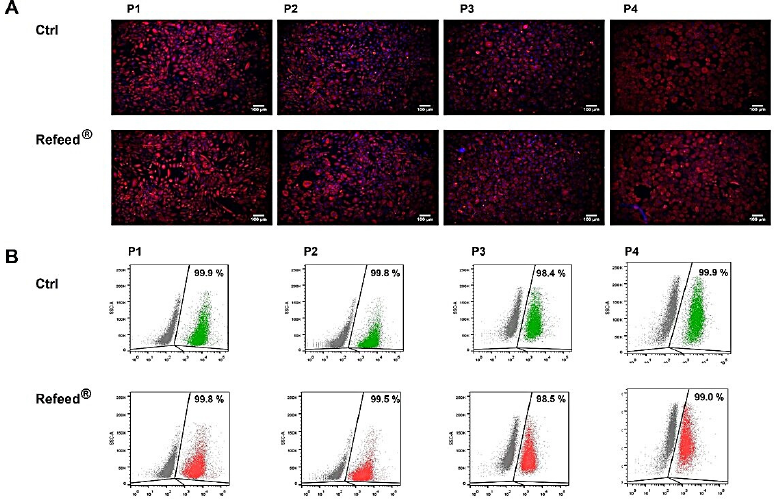
Figure 4. Expression of Pan-Cytokeratin (Pan-Ck) in human Amniotic Epithelial Cells (hAECs) cultured with and without Refeed ® supplementation. hAECs were cultured in basal medium (Ctrl) and in basal medium with Refeed ® supplement from passage 1 to passage 4 (P1–P4). ( A ) Immunofluorescence microscopy for the analysis of Pan-Ck marker (red signal); nuclei were stained with DAPI (blue signal). Images were acquired using the Nikon Inverted Microscope equipped with a Digital Sight camera DS-03. Scale bars: 100 μ m. ( B ) Flow cytometry detection of Pan-Ck marker during passages (P1–P4). Representative images were chosen from three independent immunofluorescence and flow cytometry experiments.